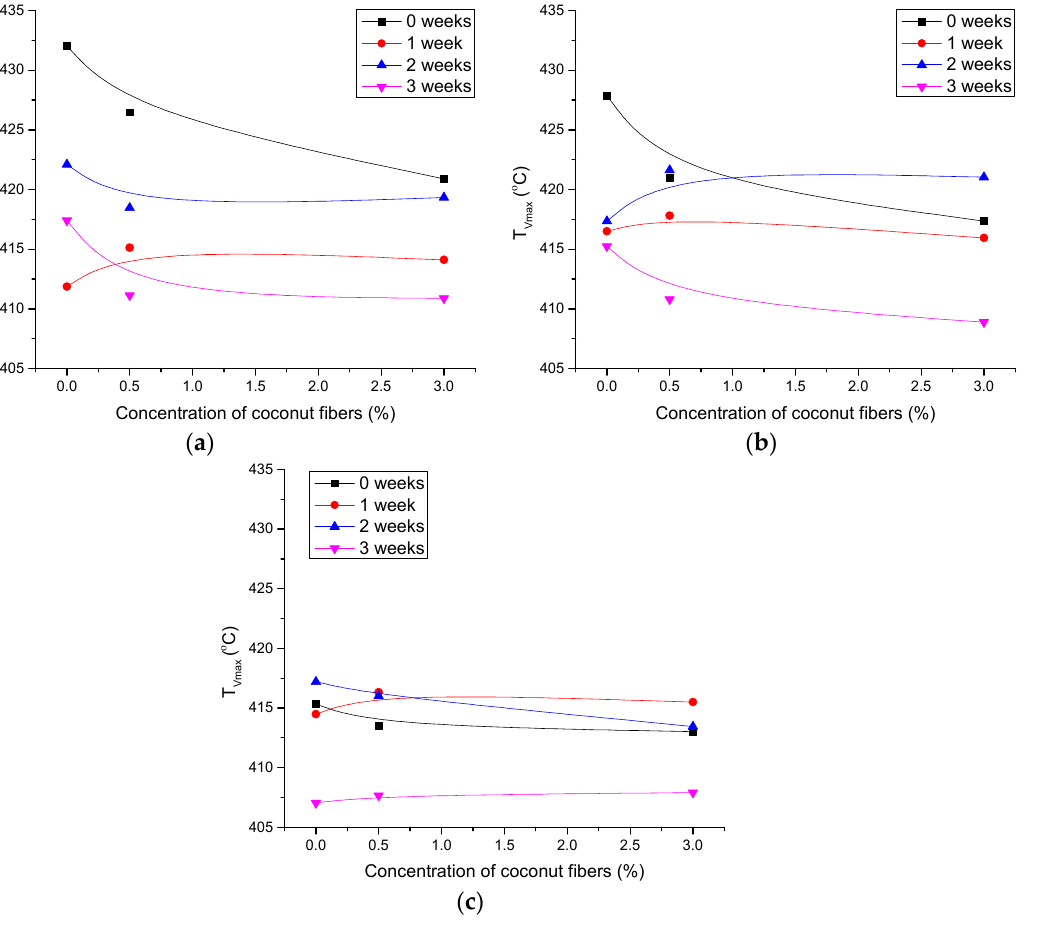
Figure 7. Temperature of maximum degradation rate for polymer blends as a function of CF concentration: ( a ) PCL-0, ( b ) PCL/PLA 80/20 and ( c ) PCL/PLA 70/30. The temperatures at the maximum rate of degradation of the blends are shown in Figure 7. The trend of changes is similar to the temperatures at which 5% and 50% weight loss